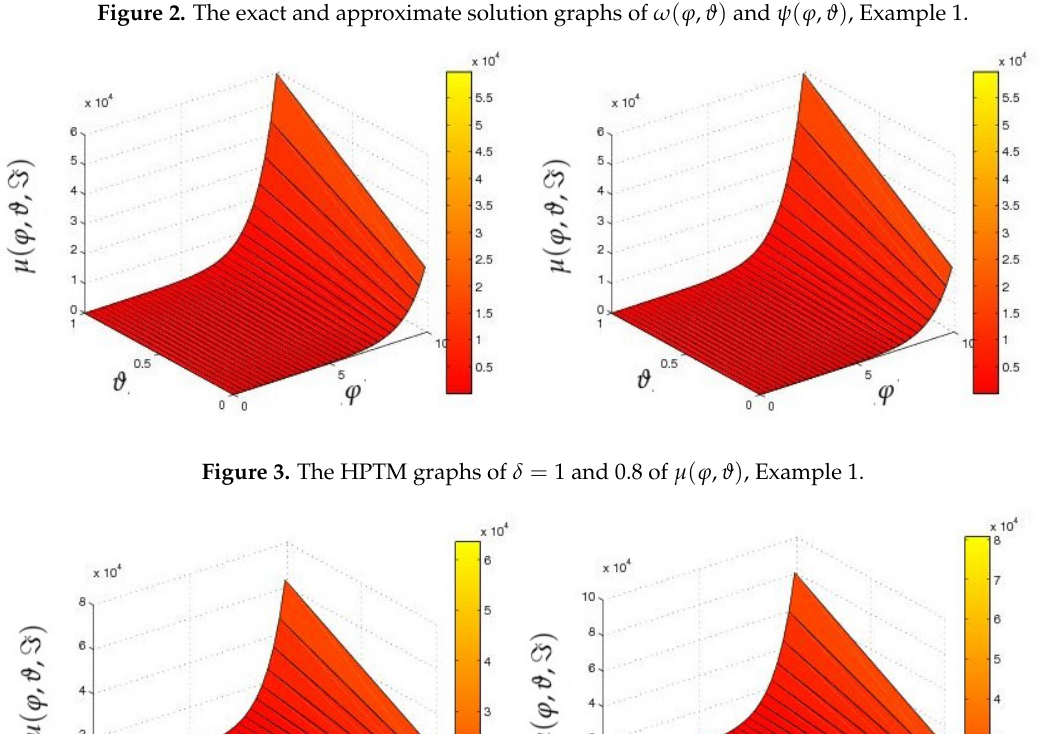
Figure 2. The exact and approximate solution graphs of ω ( ϕ , ϑ ) and ψ ( ϕ , ϑ ) , Example 1.